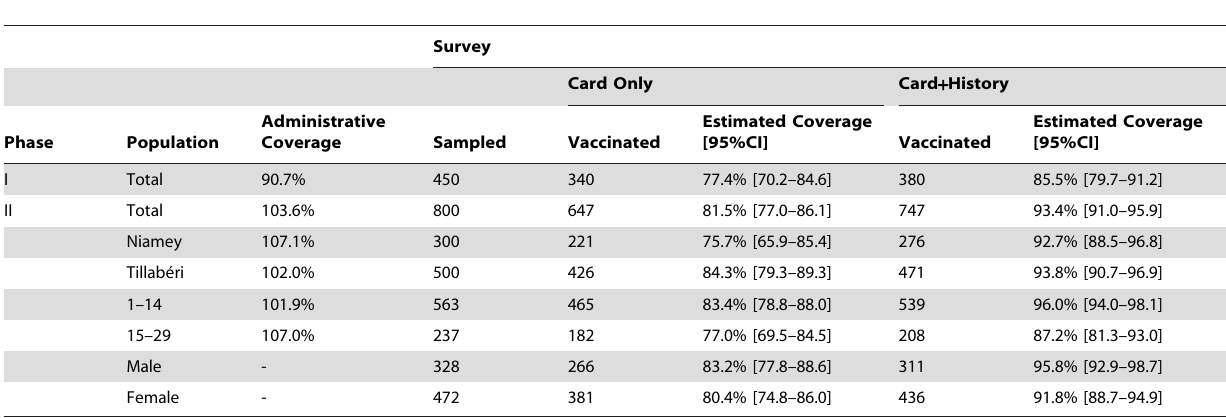
Table 1. MenAfriVac vaccination coverage in persons aged 1–29 years for the two phases presented by administrative coverage and coverage survey results, Niger, October–December